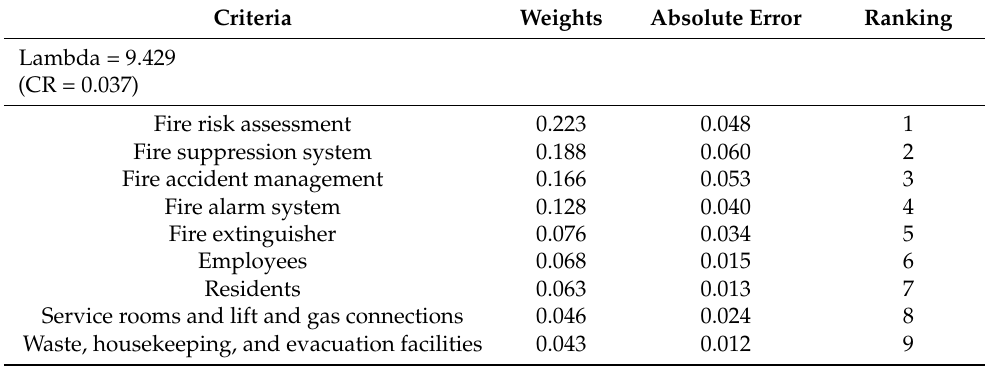
Table 1. The main elements affecting fire safety in HRBs.